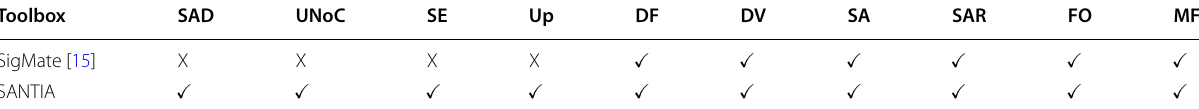
SAD state-of-the-art artifact detection, UNoC unlimited number of channels, SE supported environment, Up updates, DF digital filtering, DV data visualization, SA spectral analysis, SAR stimulation artifact removal, FO file operations, MF multiple formats